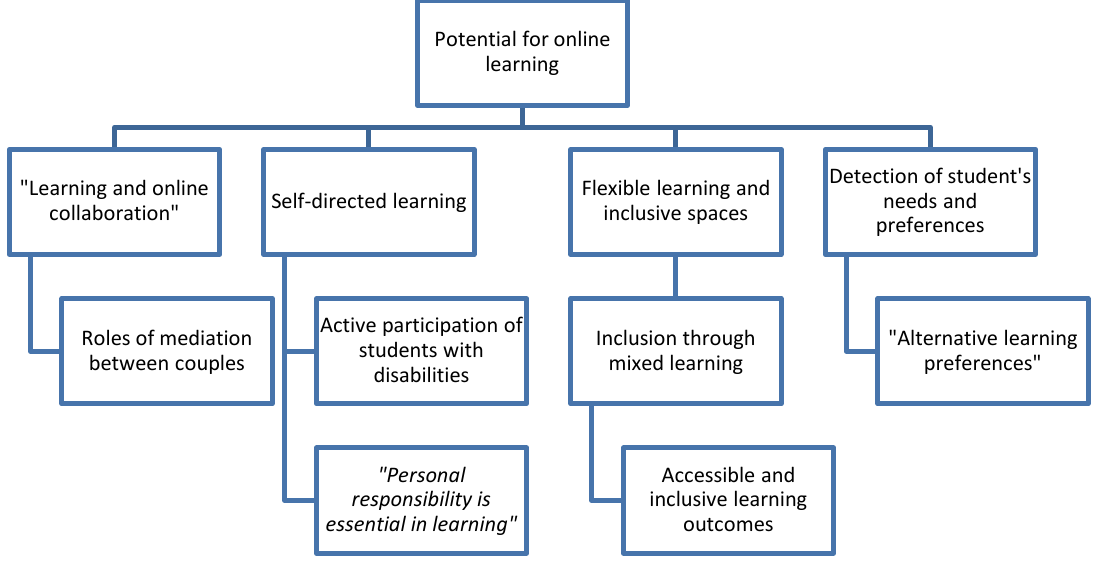
Figure 5 . Contributions to the learning process generated by distance education. This mind map illustrates the property and its dimensions. The dimensions give off codes, with some of them framed in quotation marks and italics. This is because they are "in vivo" codes and/or quotations from some of the articles studied, while the others are codes created by the